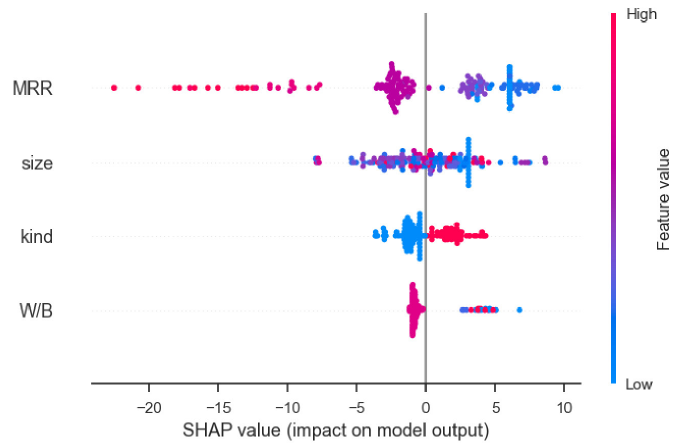
Figure 12. SHAP value summary plot for XGBoost global interpretation.